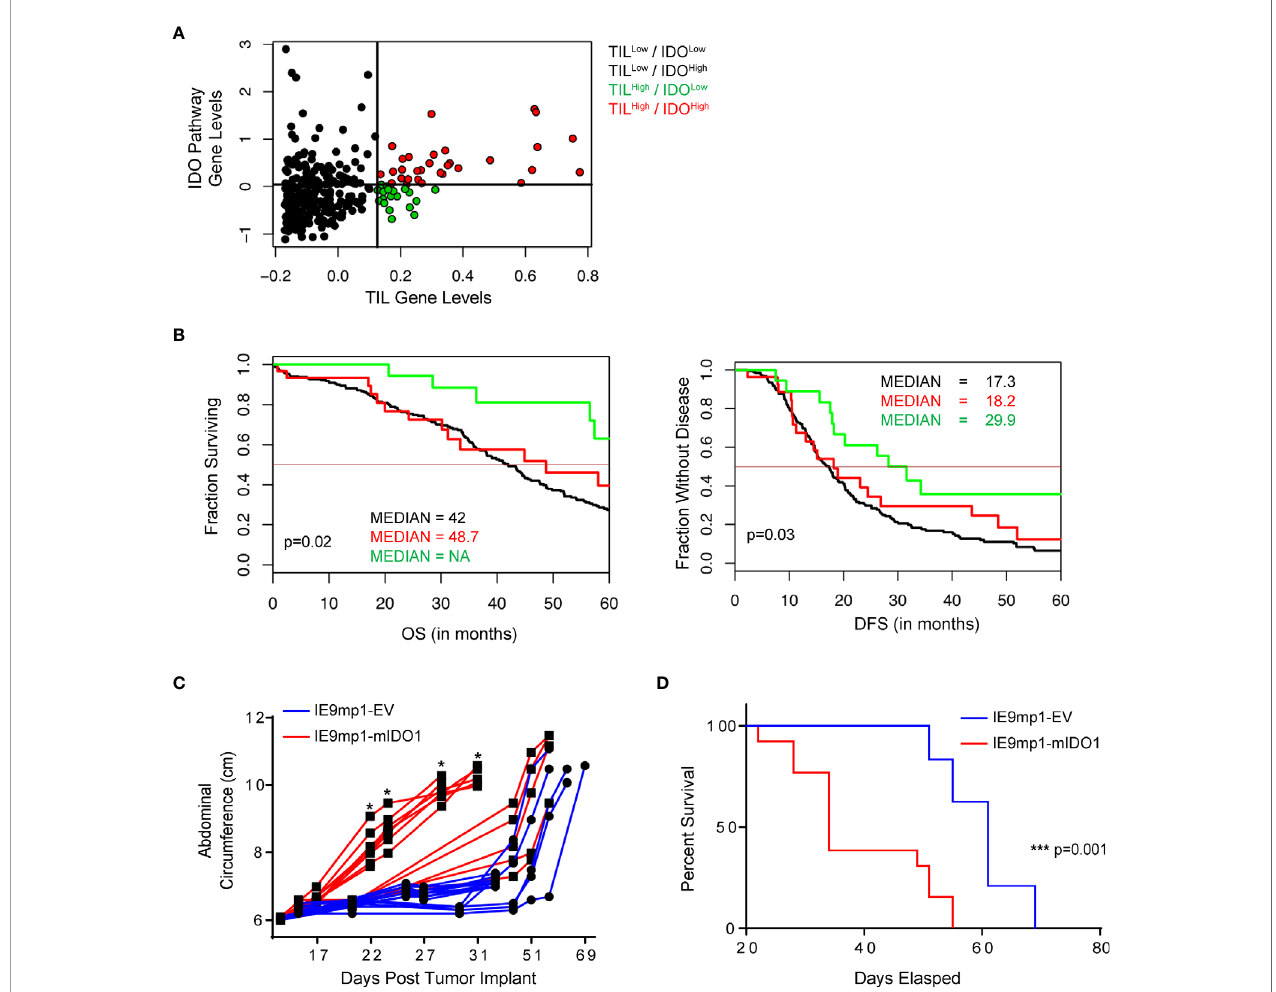
FIGURE 1 | IDO1 reduces the prognostic bene fi t of tumor in fi ltrating CD8+ T cells in human ovarian cancer and reduces overall survival in a murine model of ovarian cancer. (A) Scatterplot and (B) Kaplan-Meier curves of 4 distinct populations comprised of 265 high grade serous ovarian cancer patients from The Cancer Genome Atlas (TCGA) data set. RNA-seq data was analyzed in the context of 44 genes from the tryptophan metabolism and AHR(Aryl Hydrocarbon Receptor) signaling pathways, and CD3E, CD8A, IL2, and Granzyme B. Con fi dence intervals for the strati fi ed population of patients include OS (Overall Survival): black line median 42.0 [38.0, 46], red line median 48.7[31.2, NA] and green line median NA[57.4, NA] p=0.02; DFS (Disease Free Survival): black line median 17.3[15.1, 19.9], red line median 18.2[13.0, 48.5], and green line median 29.9[18.2, NA] p=0.03). (C) 6- to 8- week old WT C57BL/6 mice challenged i.p. with 1x10 7 IE9mp1-EV (n=10) or IE9mp1-mIDO1 (n=12) tumor cells. Tumor progression was quanti fi ed by measuring the abdominal circumference of tumor-bearing mice. (D) Kaplan-Meier curves of the survival analysis of IE9mp1-EV (n=14) and IE9mp1-mIDO1 (n=15) tumor-bearing WT C57BL/6 mice. *p < 0.05, ***p < 0.001, by the Log-rank (Mantel-Cox) test (B, D) , or Student ’ s t test (C) . NA, Not